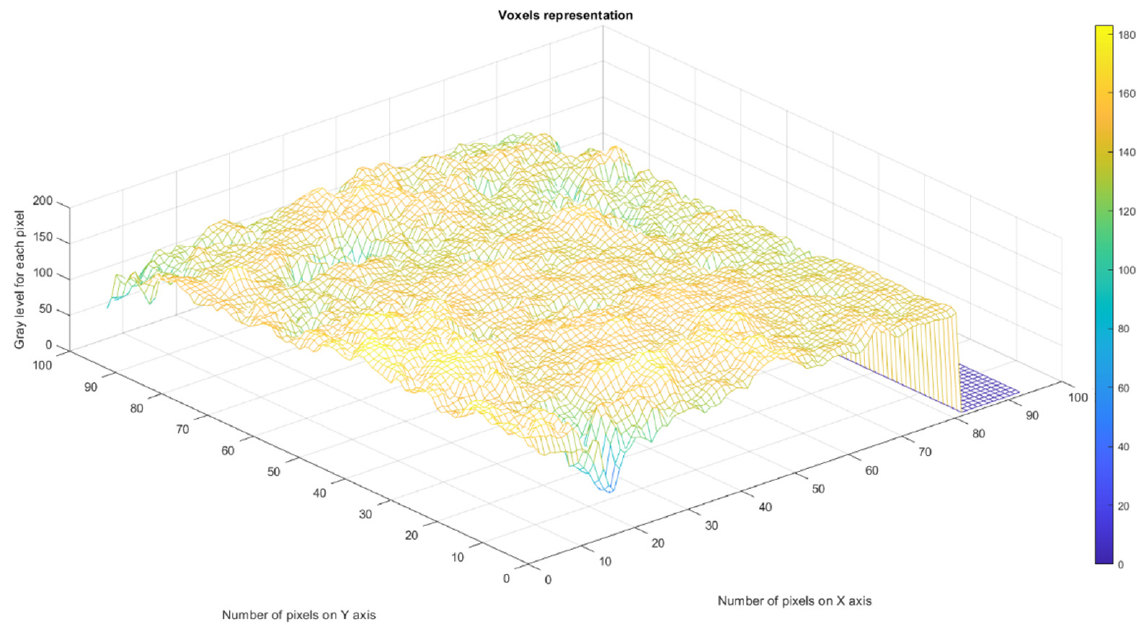
Figure 20. Voxels representation of the image in the unaffected area.